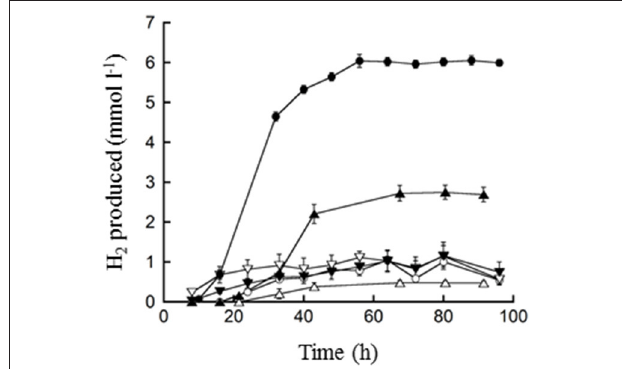
FIGURE 4 | H 2 production by T. paralvinellae (filled symbols) and P. furiosus (open symbols) when grown on spent brewery grain. The concentrations spent grain used were 10 ( Error bars represent the standard error.